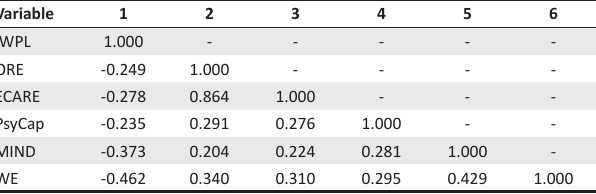
TABLE 2: Correlations.